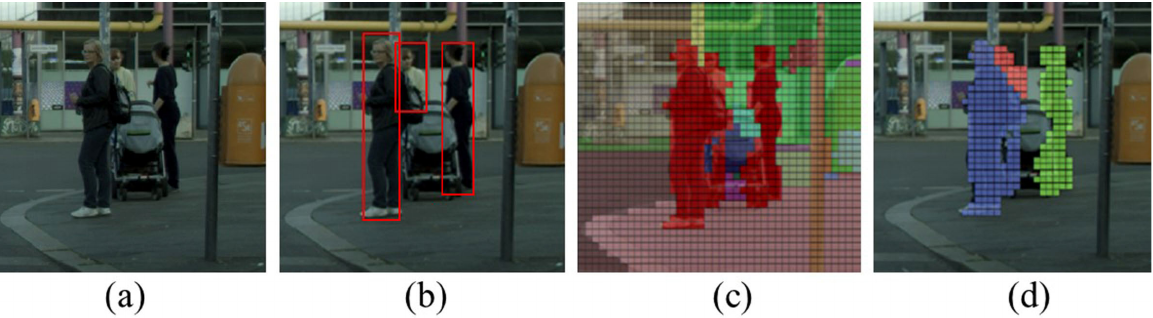
Figure 8. The comparison of the original image ( a ), target detection image output by YOLO ( b ), the semantic segmentation image output by PSPNet ( c ) and target detection image output by seed points spreading algorithm ( d ).